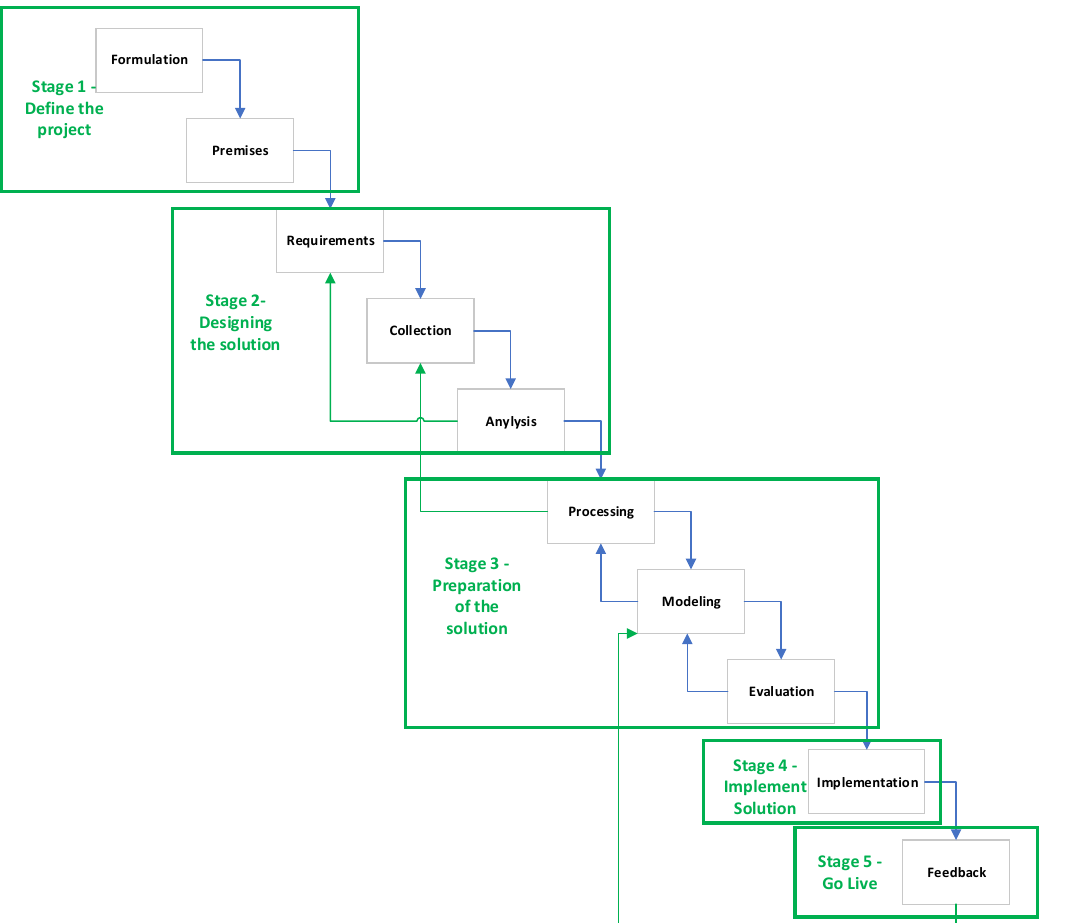
Figure 4. The implementation of the forecasting module, requires more steps than the implementation of other ERP modules due to the analytical nature of the module. The required additional steps have been embedded into the steps of the standard ERP implementation